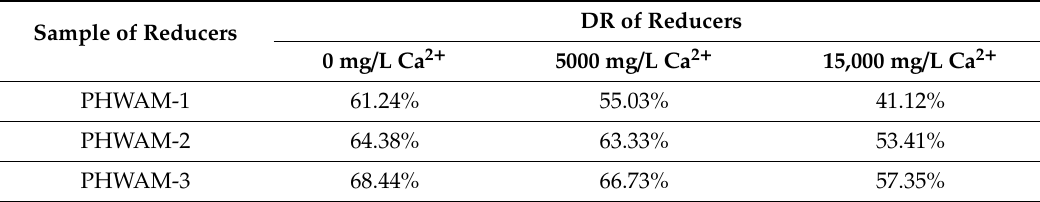
Table 3. The e ff ect of Ca 2 + on samples in brine (10 × 10 4 mg / L). Table 3. The effect of Ca 2+ on samples in brine (10 × 10 4 mg/L).